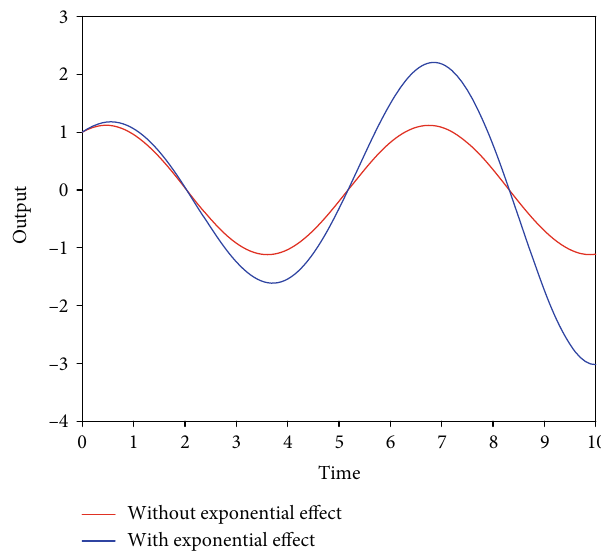
Figure 2: Comparison of the harmonic curve with and without an exponential e ff ect.